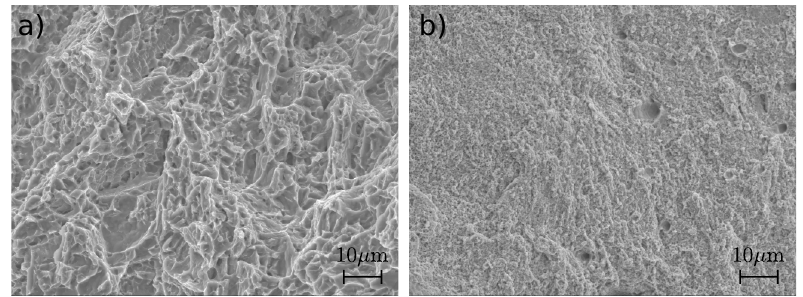
Figure 7. Micrographs of fracture surfaces of the specimens after tensile test made of ( a ) titanium alloy Ti6Al4V and ( b ) stainless steel